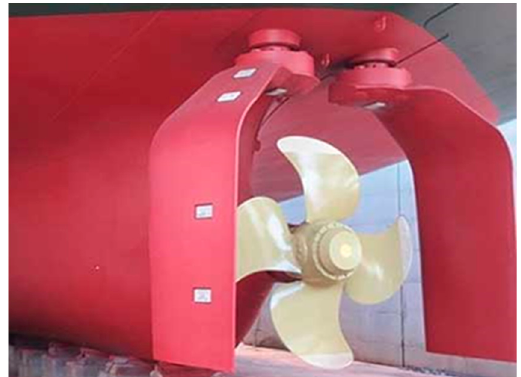
Figure 11. Gate rudder used in a sea trail, reproduced from [108] (CC BY).